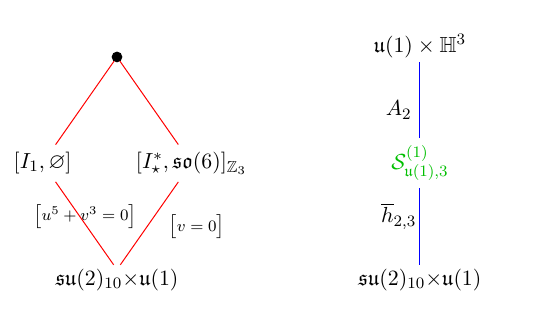
Figure 35. Information about the su (2) 10 × u (1)